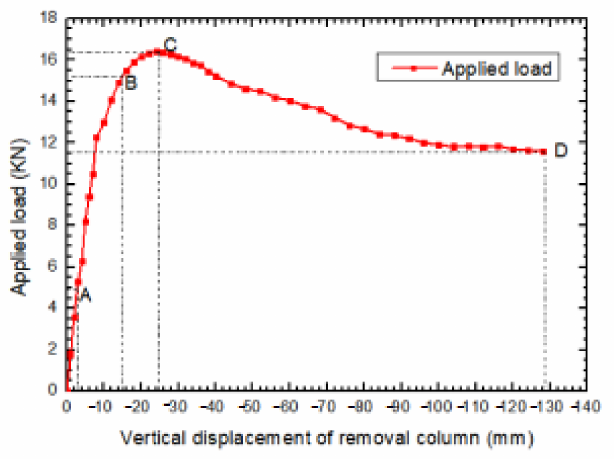
Figure 6. Static load-vertical displacement curve of the frame specimen with column removal.